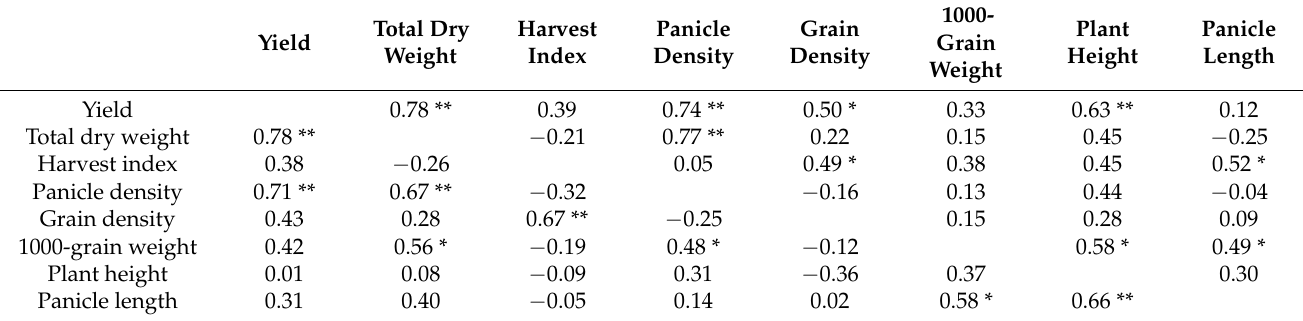
Table 3. Pearson partial correlation coefficients for yield and growth characteristics in 2017 and 2018.